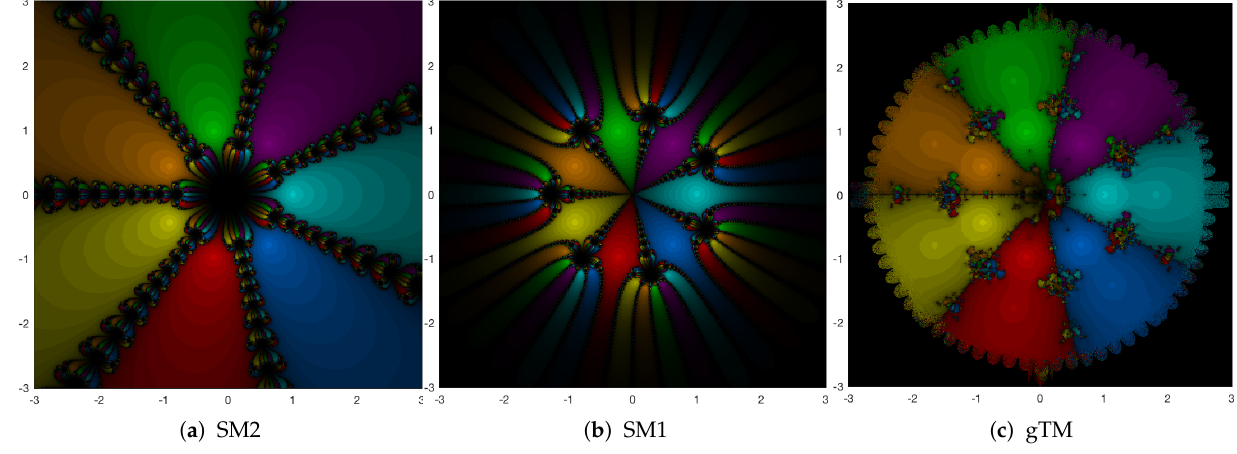
Figure 8. Dynamical planes of Schröder methods and gTM on f 6 ( x )